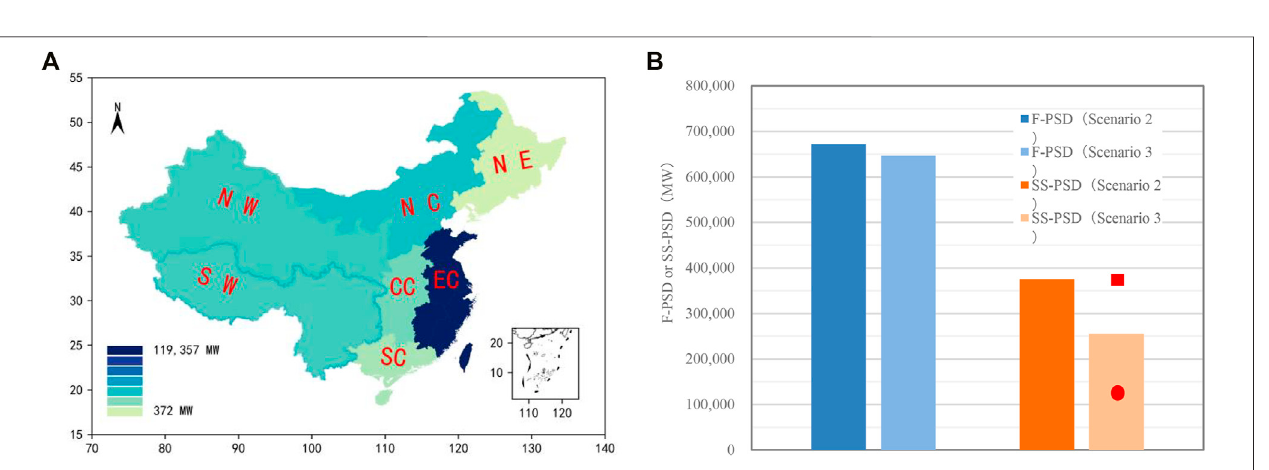
NC, NE, EC, CC, SC, SW, NW, respectively represent North China, Northeast China, East China, Central China, South China, Southwest China, Northwest China; id-PSD, iw-PSD, respectively represents intra-day SS-PSD, and intra-week SS-PSD; wd, hd respectively represent workdays and holidays; The reduction rate is the ratio of the Total-PSD, reduction between Scenario 2 and 3 to the Total-PSD, in Scenario 2.